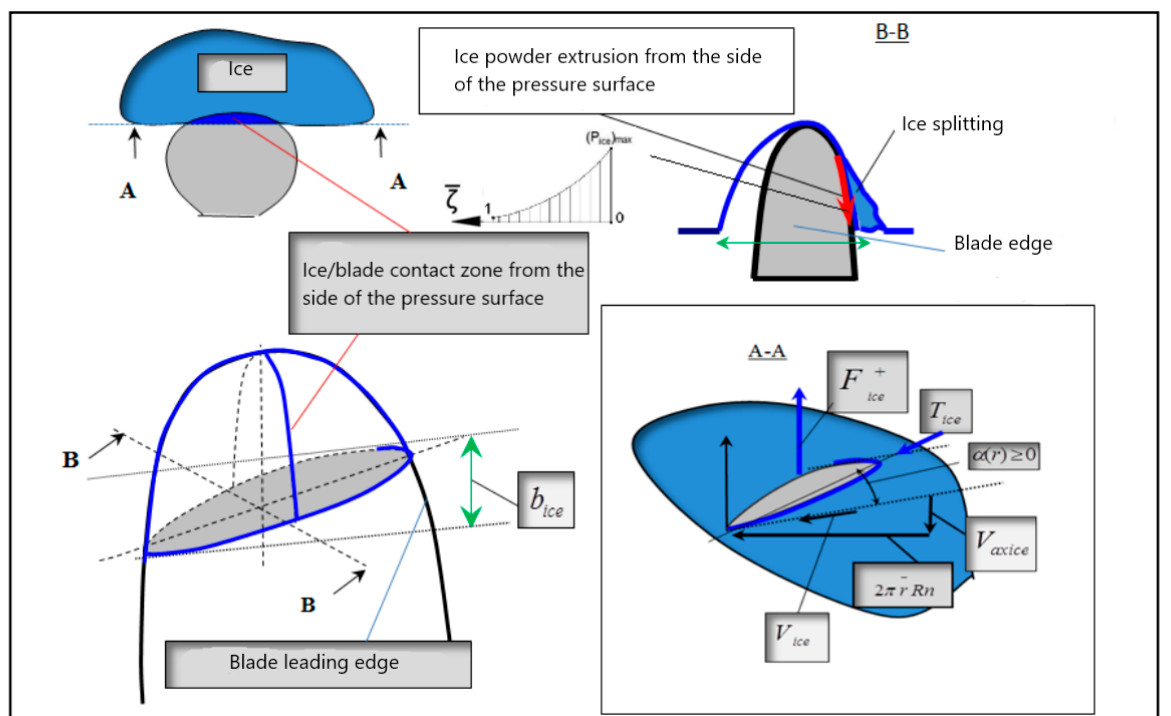
Table 1. The results of ice profile resistance calculations both for the original and modified propel- ler blade profiles at zero angle of attack. Relative ice profile resistance (𝐹 (cid:3036)(cid:3030)(cid:3032)(cid:3051) ) (cid:3046)(cid:3035)(cid:3028)(cid:3045)(cid:3043) /(𝐹 (cid:3036)(cid:3030)(cid:3032)х ) (cid:3029)(cid:3039)(cid:3048)(cid:3041)(cid:3047) . From the Suction Side From the Pressure Side Total Force Modified (sharp) profile 0.78 0.76